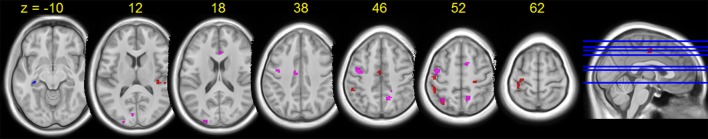
Group T-statistic maps for the regions showing HDBR-related changes in dual tasking cost of brain activation, thresholded at abs (T) > 3.218. Red: HDBR-related cumulative increases; blue: HDBR-related cumulative decreases; violet: HDBR-related immediate increases.